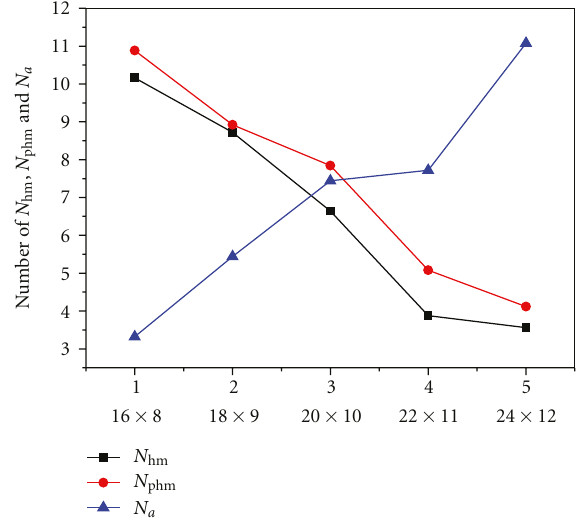
Figure 8: Impact of N h on N hm , N phm and N a .